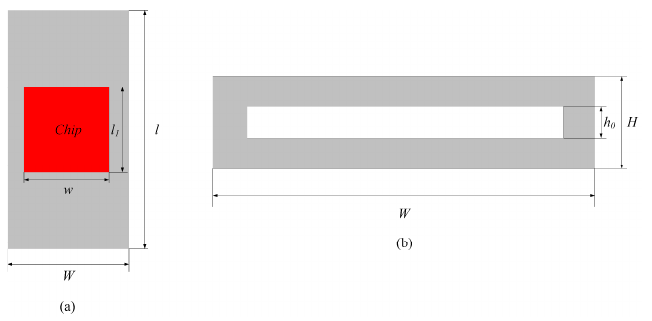
Figure 2. Schematic diagram of channel: ( a ) Vertical view; ( b ) Side view. When the DSJA diaphragm is not vibrating, the actuator only acts as a fluid circuit. At this time, jets from the jet orifices can be regarded as steady jets. When the DSJA diaphragm vibrates upward, the cavity on the upper side of the actuator shrinks, and fluid is ejected from the third, fourth, and fifth-row jet orifices. At the same time, the cavity at the lower side of the actuator expands, and the fluid in the channel flows into the cavity at the lower side through the 1st and 2nd discharge orifices. When the DSJA diaphragm vibrates downward, the flow situation is opposite to the above process. Different jet outlets alternately eject/inhale fluid, and the formed jets fuse and develop with each other, and interacts with the incoming flow of the channel to form a violent